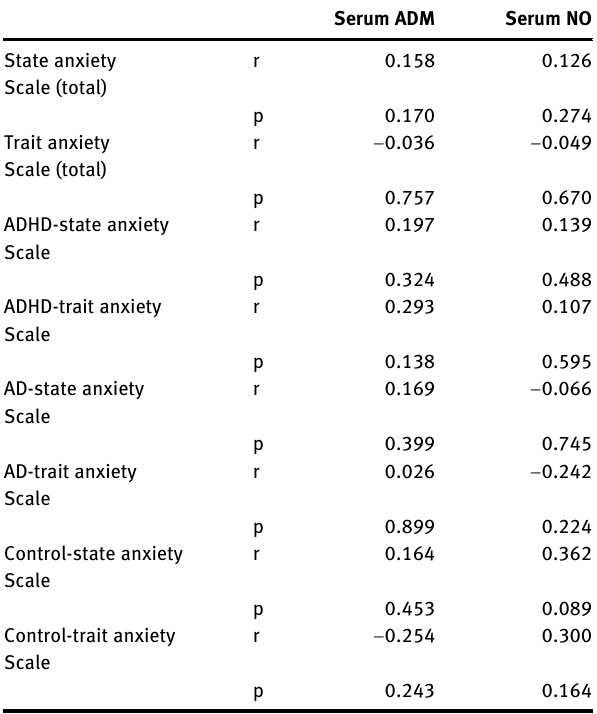
Table  : Relationship of serum adrenomedullin and nitric oxide levels with state-trait anxiety